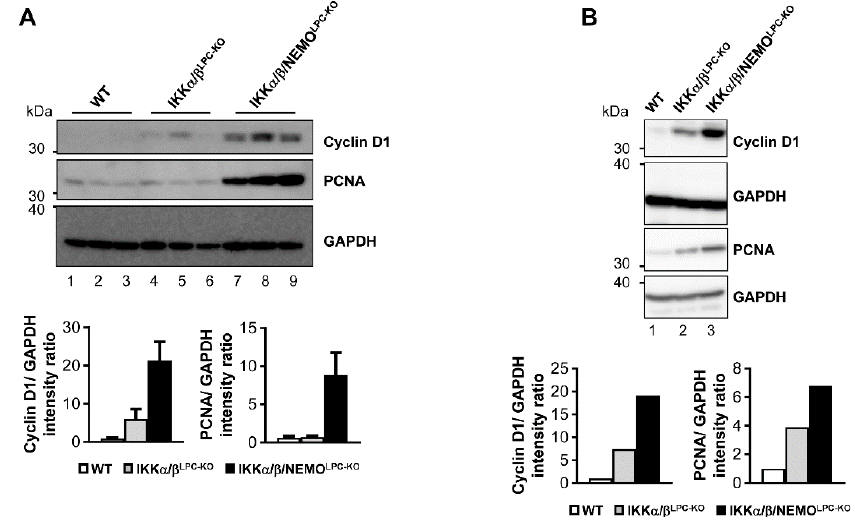
Figure 4. Enhancement of compensatory proliferation in IKK α / β / NEMO LPC-KO mice. ( A and B ) Immunoblot analysis of Cyclin D1, PCNA and GAPDH (loading control) in three whole liver- ( A ) and primary hepatocyte- ( B ) protein extracts from male WT, IKK α / β LPC-KO and IKK α / β / NEMO LPC-KO mice and relative intensity ratios.